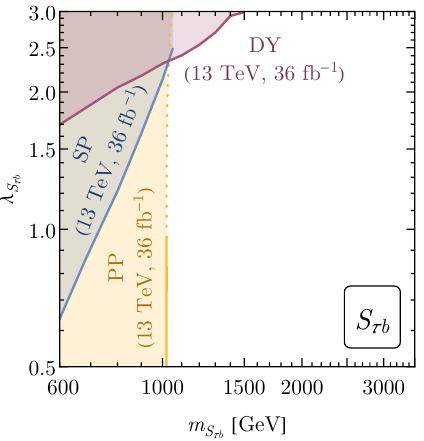
Figure 10. 95% CL limit on the parameter space for scalar MLQ S limit is recast from [62]. The single-production (SP) limit is given by [73], and the DY limit is recast from [105]. All searches are from Run 2 with 36 fb (cid:0) 1 of data.